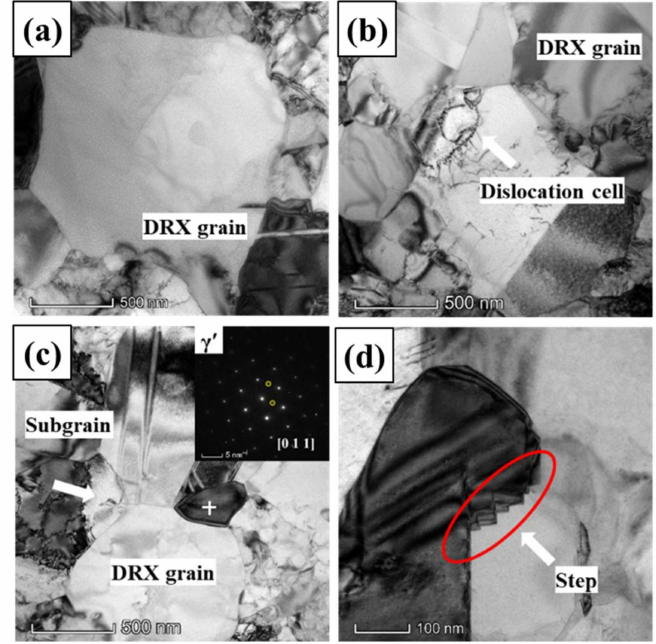
Figure 10. TEM images of GH4151 alloy after deformation at 1040 ◦ C, 0.1 s − 1 and strain of 0.7: ( a ) DRX grain; ( b ) Dislocation cell and DRX grain; ( c ) subgrain and DRX grain; ( d ) Step-shaped grain